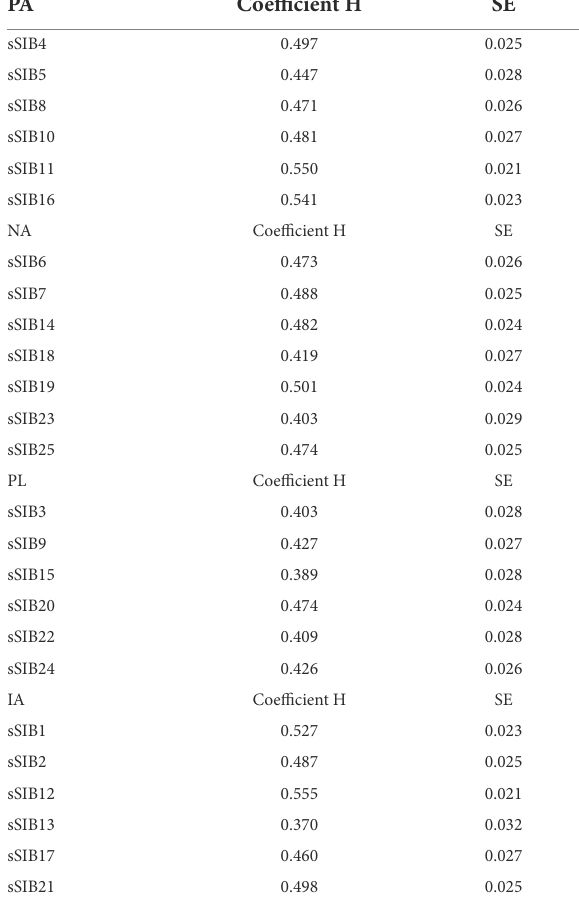
TABLE 5 Coefficients of item scalability for s-SIB